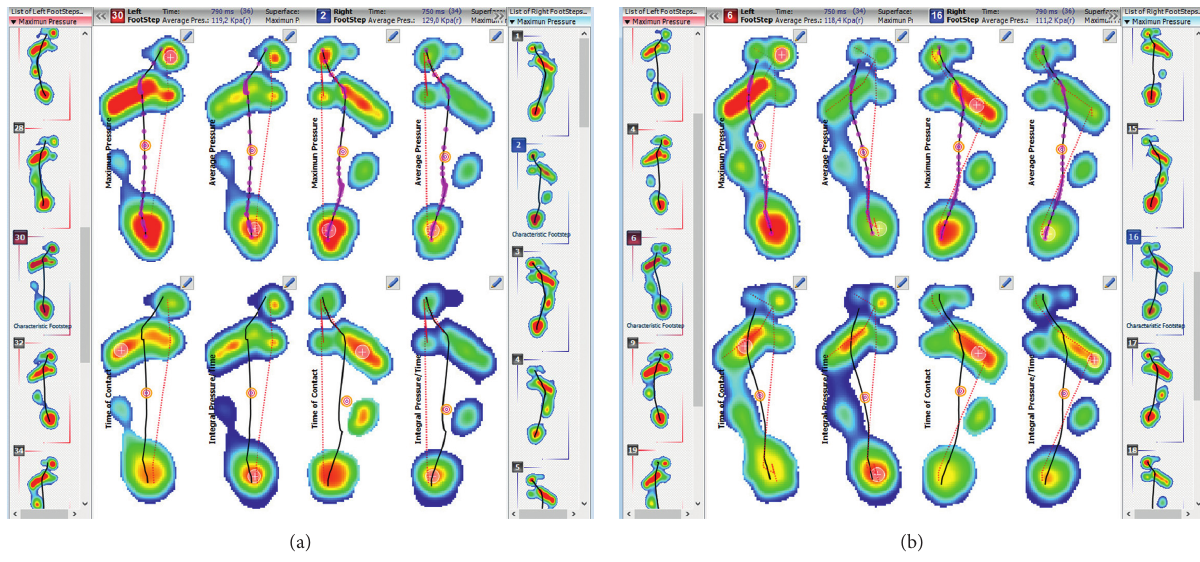
Figure 12: The exemplary result of the assessment of foot progression, carried out (a) before and (b) after a therapeutic